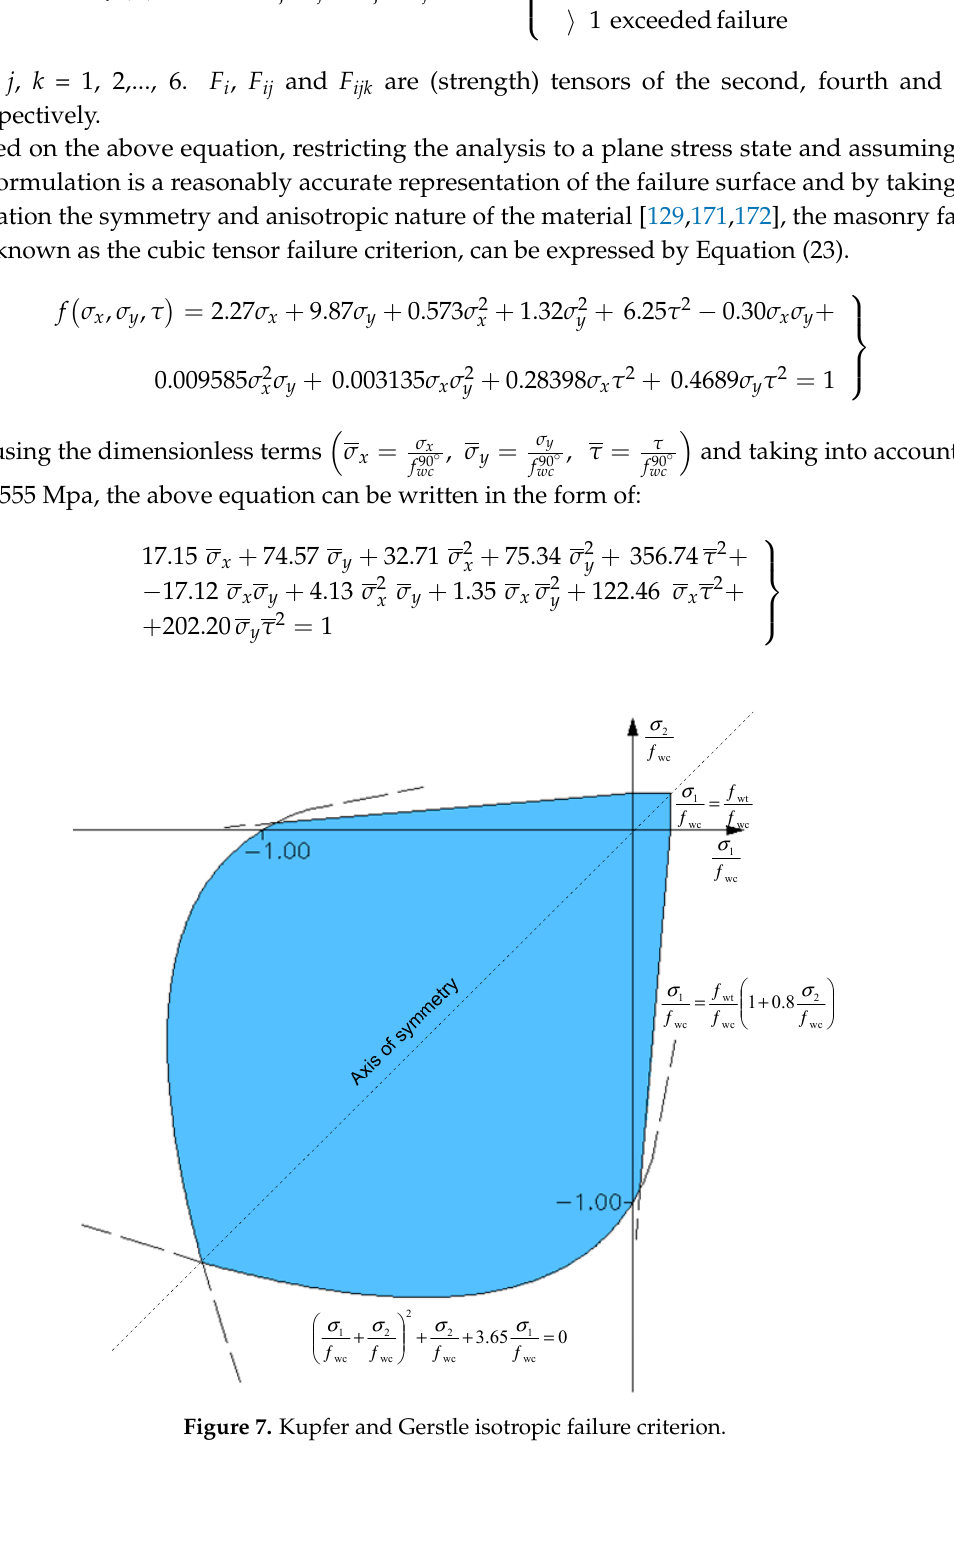
ƒ1 ƒƒ ƒ σσ Figure 8. Von Mises modified isotropic failure criterion.